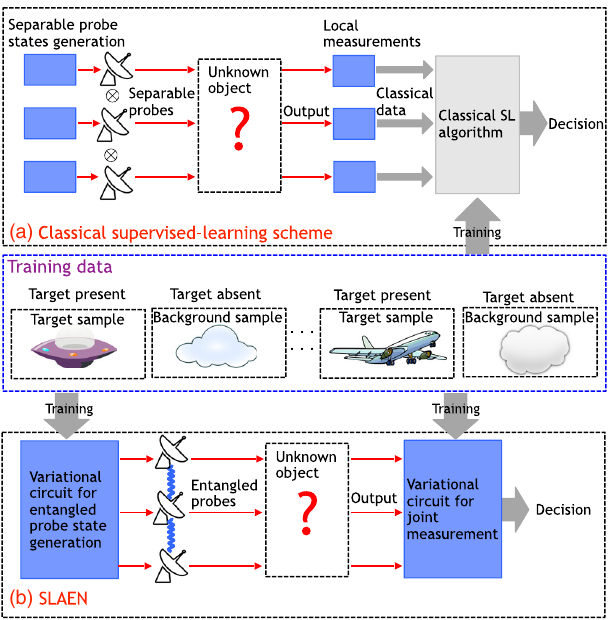
FIG. 2. A classical SL scheme versus SLAEN in a data classification task for target detection. (a) In a classical SL scheme without entanglement, the separable sensor network is connected with a classical SL algorithm. Separable probe states and local measurements are employed to investigate an unknown object. The classical data acquired by measurements are fed into a classical SL algorithm to make a decision. (b) In SLAEN, the sensors, represented by the probe icons, share a multipartite- entangled probe state. Each sensor sends its share of the entangled probe state to investigate an unknown object. The sensing process is modeled as parameter estimation of quantum channels. Each sensor views the object from a different perspec- tive, and their shared entangled probe state boosts the perfor- mance of estimating global parameters of the object. Prior to interrogating an unknown object, existing data are used to train the first variational circuit (left blue box) to generate the optimum entangled probe state and the second variational circuit (right blue box) to perform the optimum